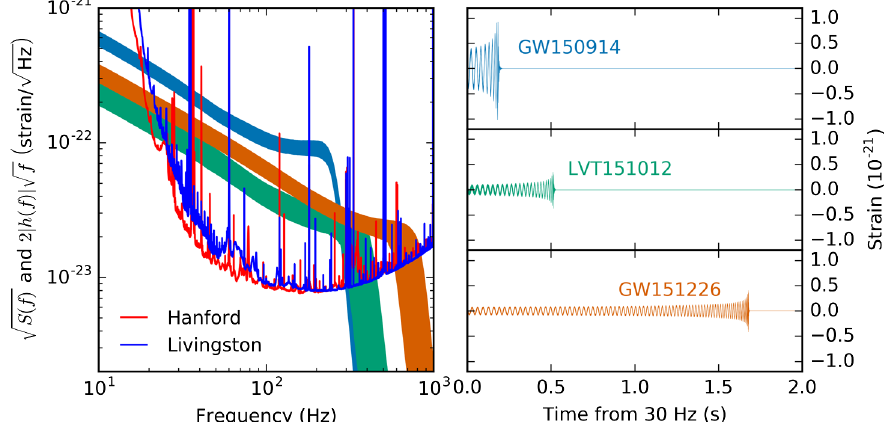
ffiffiffiffiffiffiffiffiffi p ffiffiffiffiffiffi p S ð f Þ , in units of strain per Hz ,